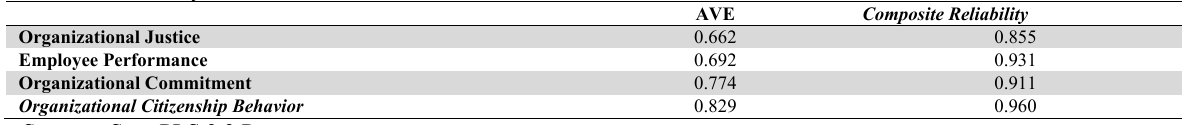
Construct Reliability